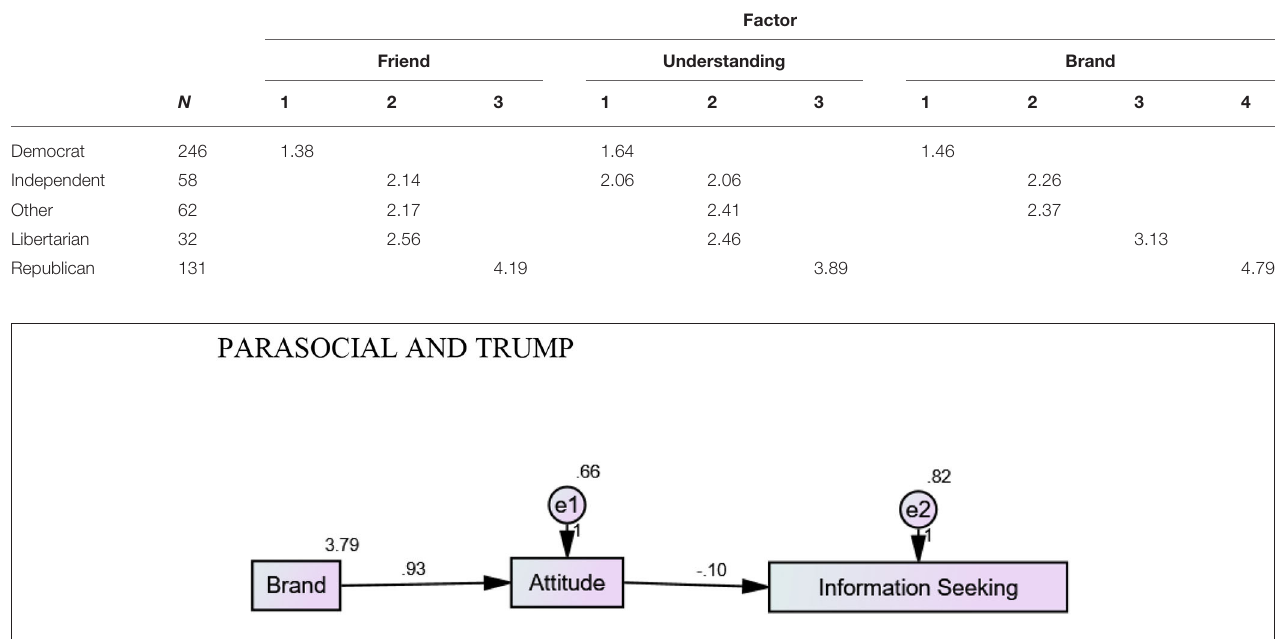
FIGURE 2 | Supported model.